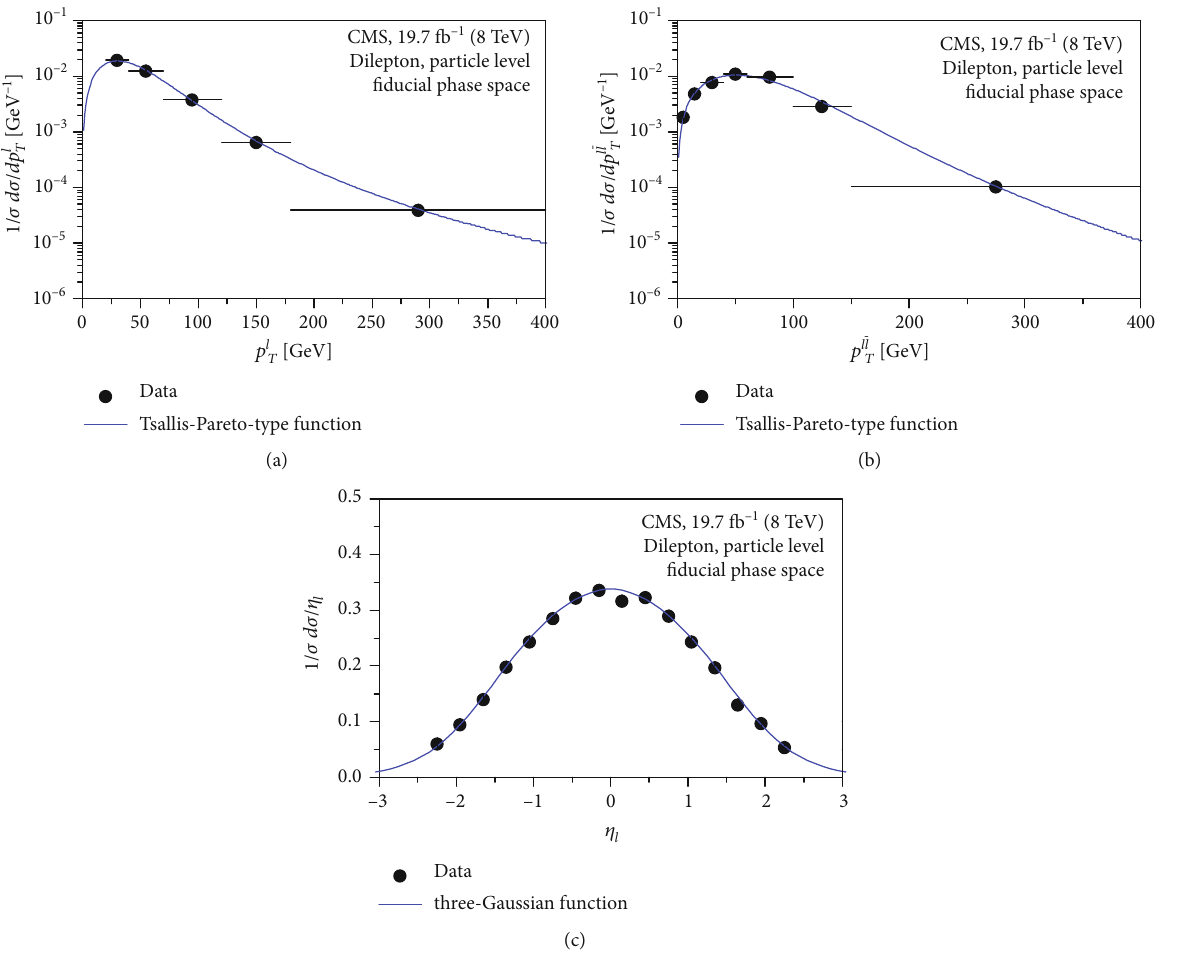
Figure 15: The same as Figures 1 and 5, but showing the results of l and l (cid:1) l produced in pp collisions at the particle level in the fi ducial phase ffiffi p s = 8 space at